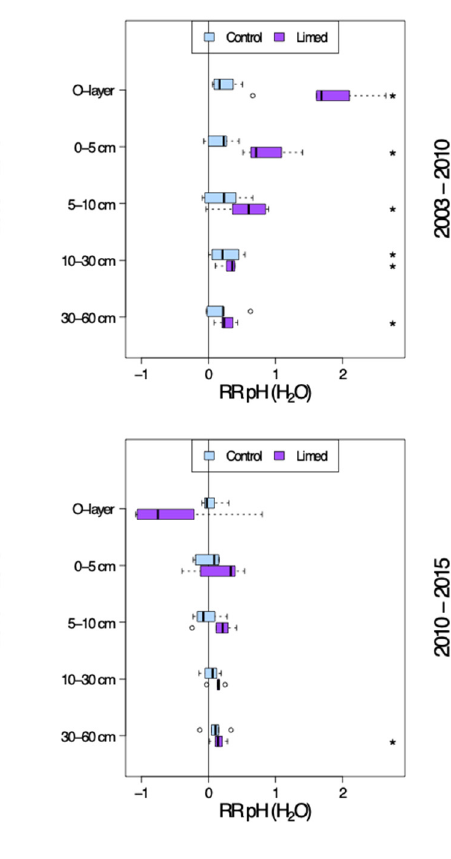
Figure 2. pH-H 2 O in the soil profiles of control and lime treated plots in 2003–2015. ( a ) G1 study sites. ( b ) G2 study sites. #—limed plots significantly different from control; *—significant differences between current and previous sampling campaign.